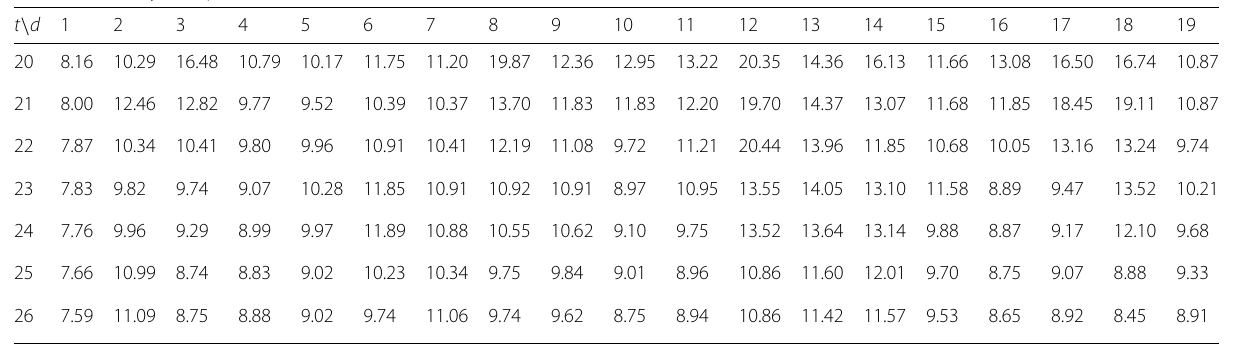
Table 6 Penalty unit